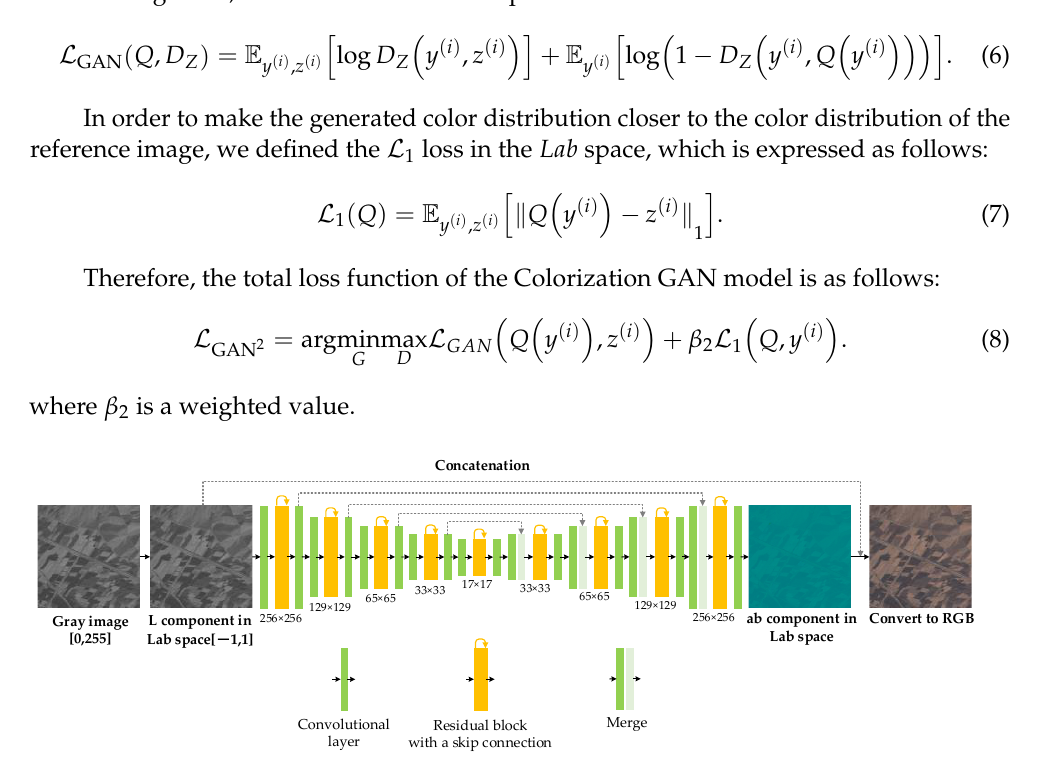
Figure 7. The network structure of the Colorization GAN generator. The gray image of the input model is first transformed into the L channel in the Lab color space and then trained to map to the AB channels through the network. The obtained hue is spliced with the gray image to get the Lab color image. Finally, the Lab image is transformed into an RGB image. The green block represents the convolutional layer, the yellow block represents the residual block, and the green and light-green blocks represent the average by merge.